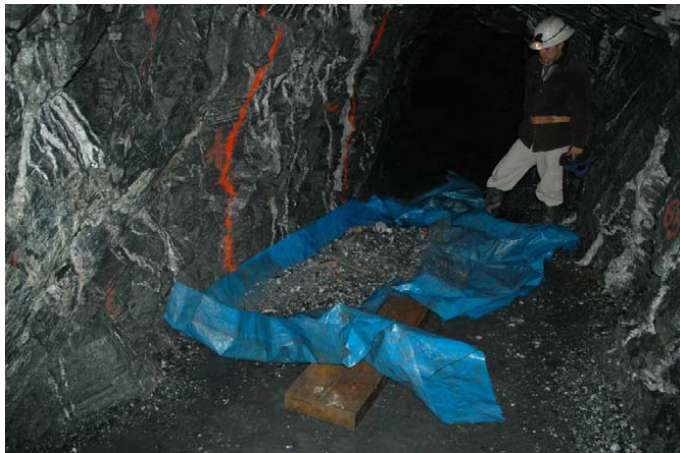
Figure 3. Collection of metallurgical sample via underground panel sampling.